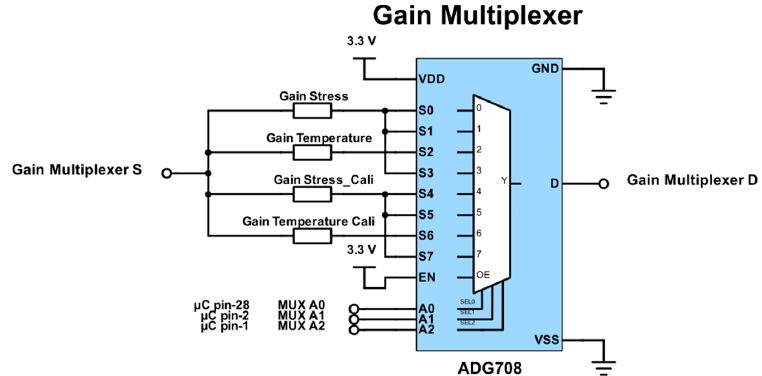
Figure 13. Circuit schematic of the preamplifier gain multiplexer.